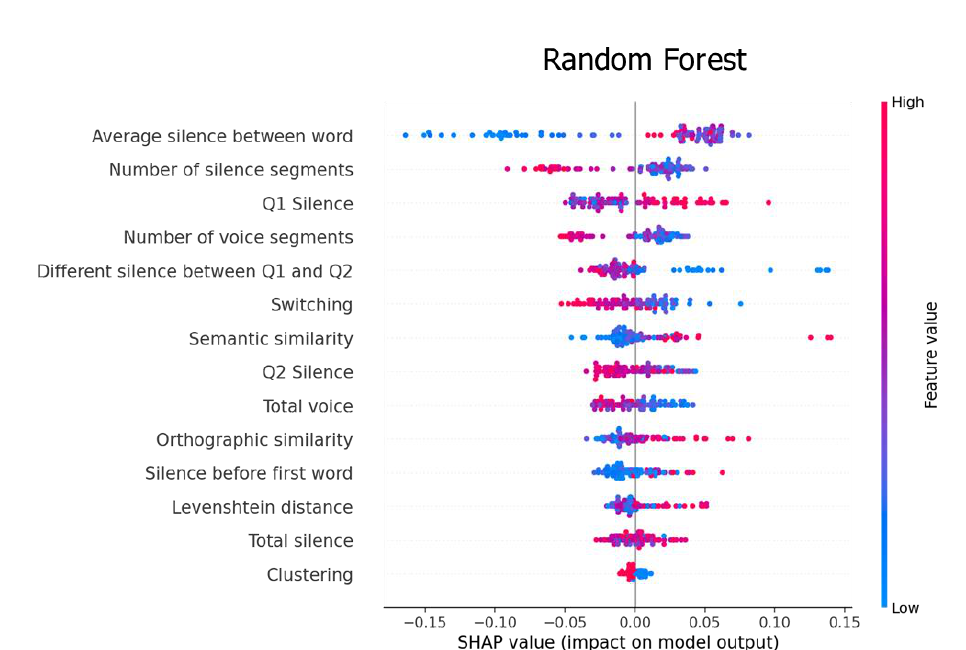
Figure 5. Feature importance explained by the SHAP value for the random forest classifier.